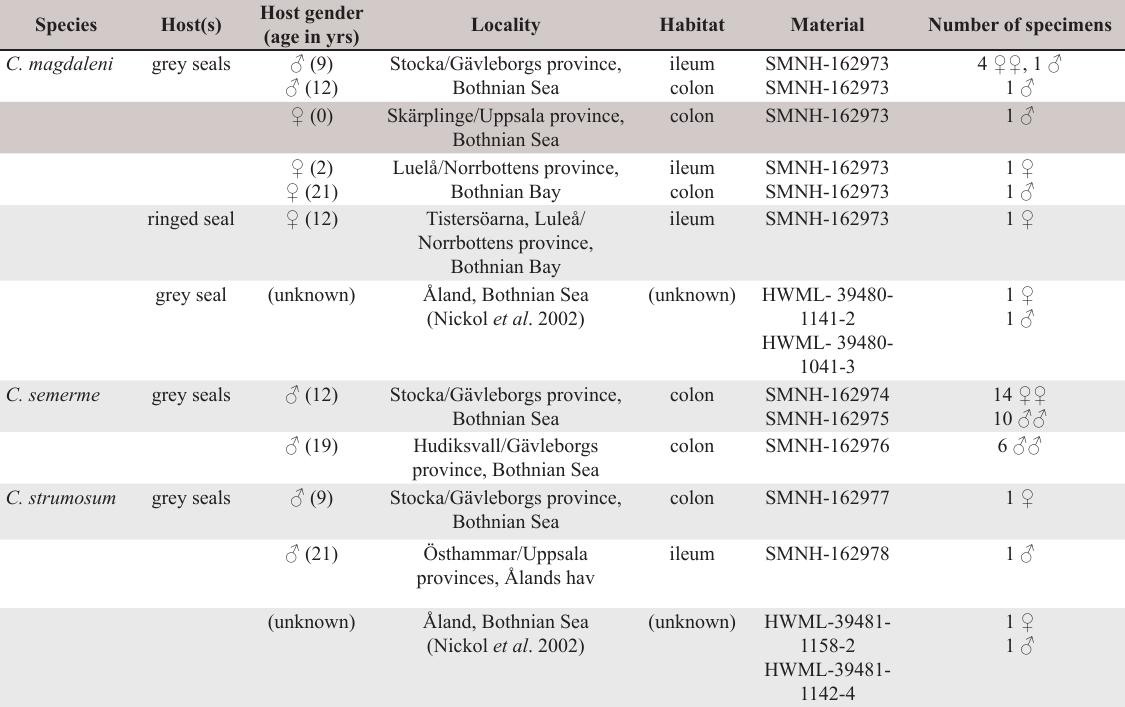
Table 1. Material of Corynosoma magdaleni , C. semerme and C. strumosum studied from seals in the Baltic Sea and studied by SEM and/or LM. Abbreviation: yrs =